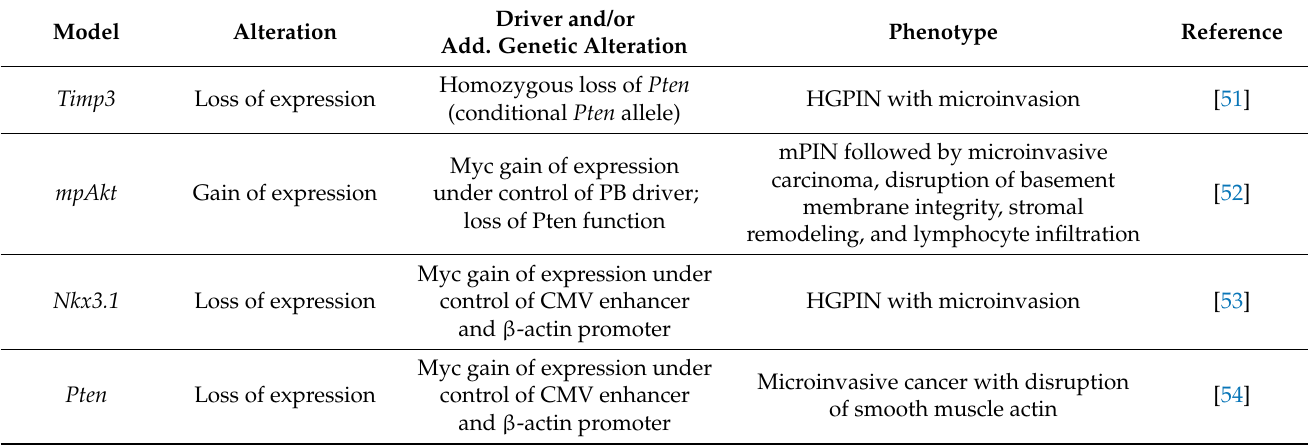
Table 4. PCa models in which microinvasive carcinoma is